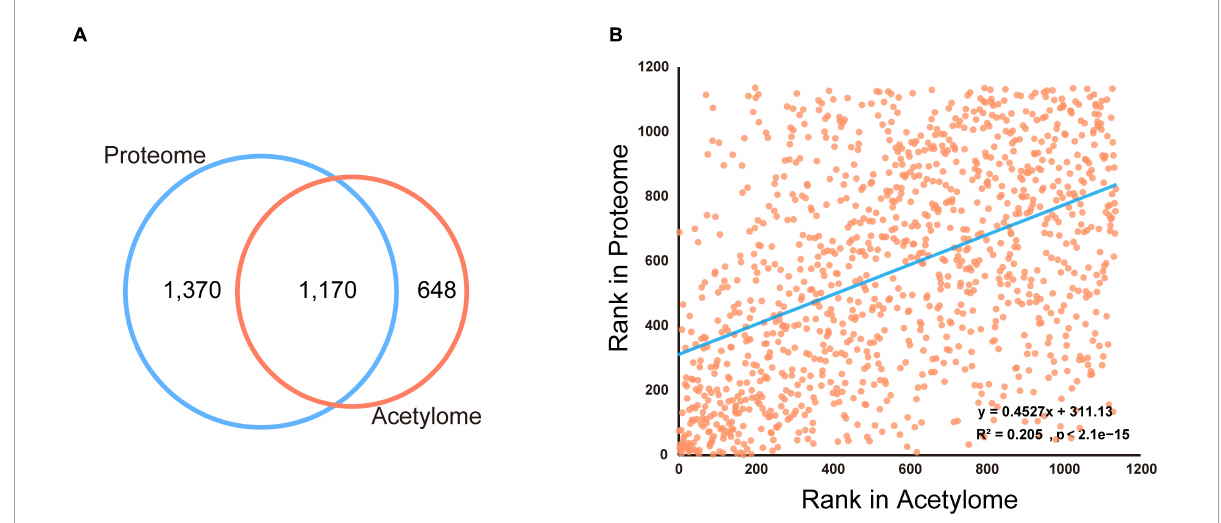
FIGURE3 Comparison of the proteome and acetylome of mouse brain. (A) Venn diagram showed the overlapped proteins identified in the mouse brain proteome and acetylome. (B) The dot plot showed a weak correlation between protein abundance and acetylation modification in the mouse